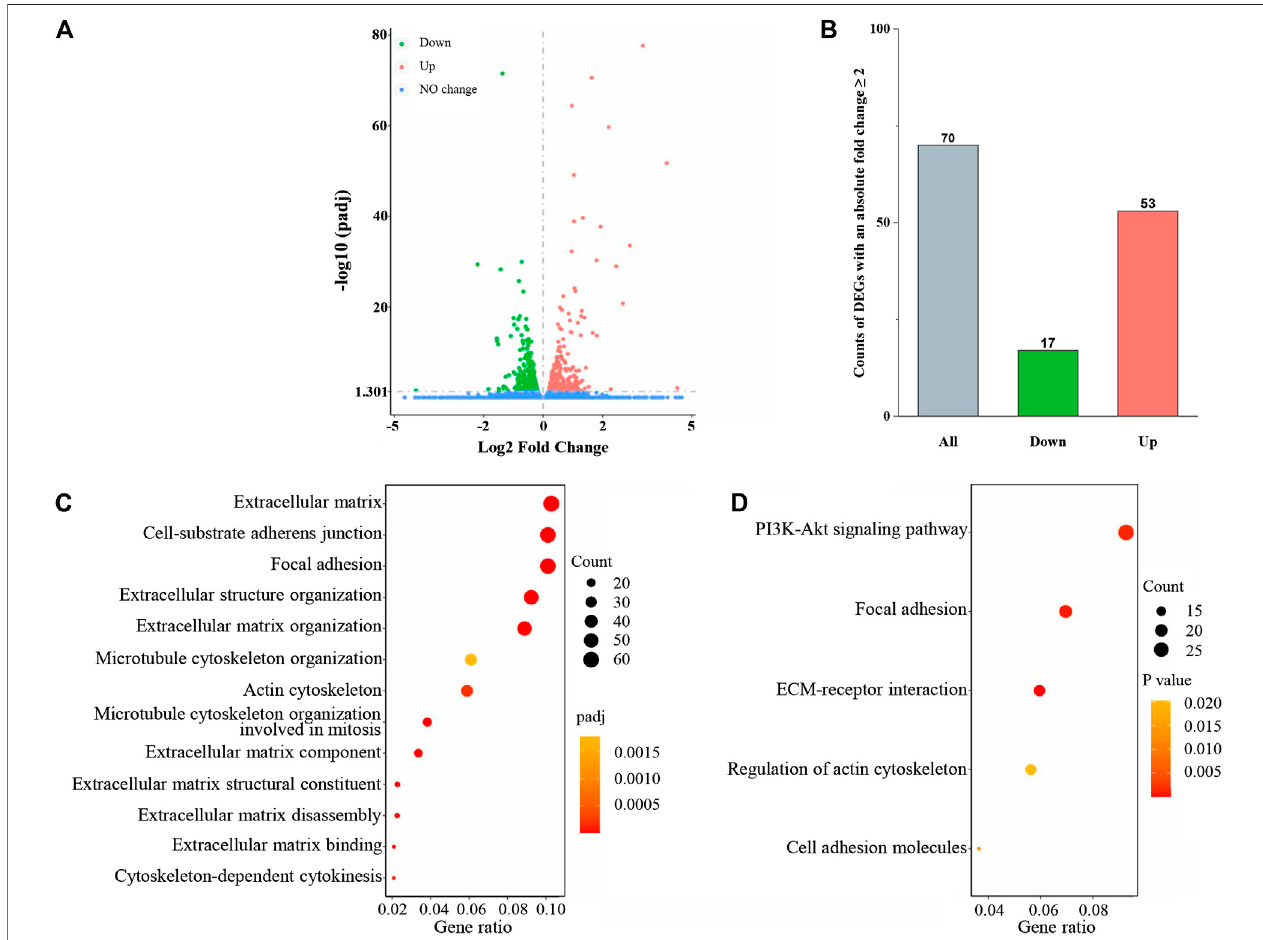
FIGURE 3| PvSRA signi fi cantly induced gene expression changesin HSF. (A) Volcano plot ofthe DEGs. (B) Histogram ofthe count ofDEGs withan absolute fold change ≥ 2. (C) GO enrichment analysis of the DEGs obtained from RNA-seq. (D) KEGG enrichment analysis of the DEGs obtained from RNA-seq.